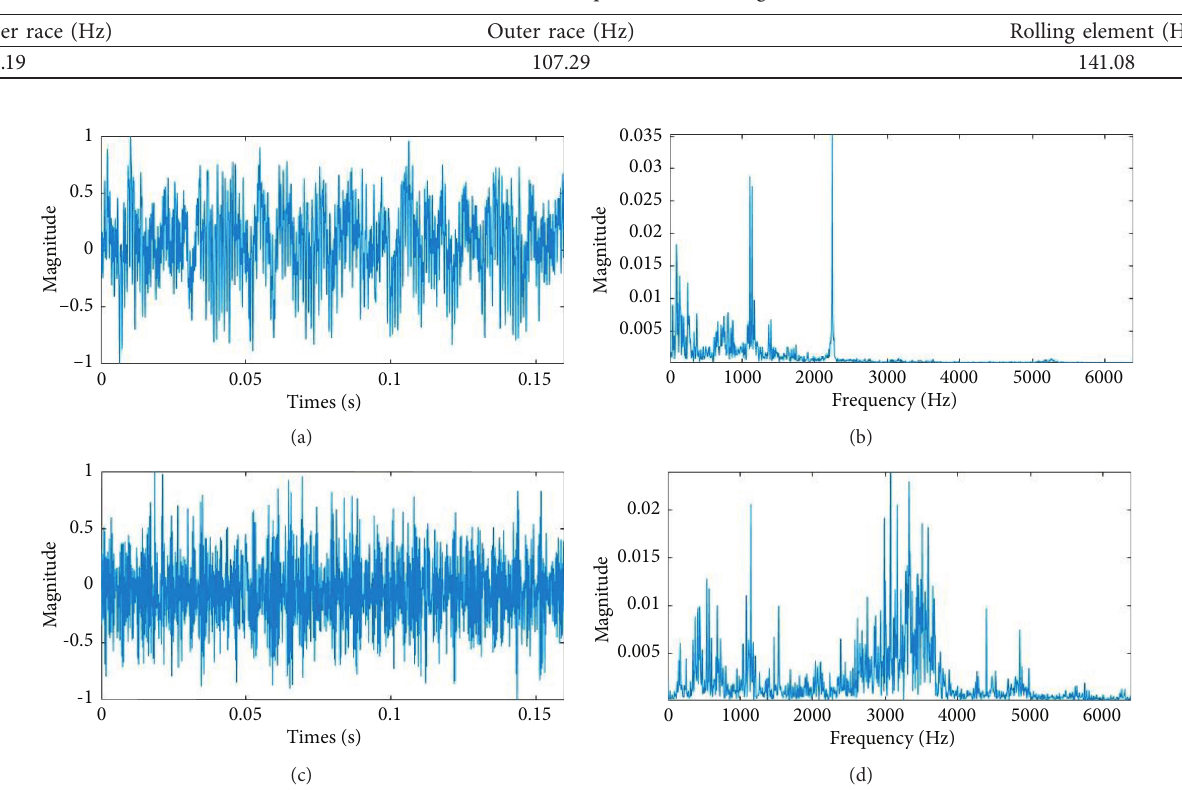
Figure 2: Block diagram of the implemented method. Table 1: Characteristic frequencies of bearing